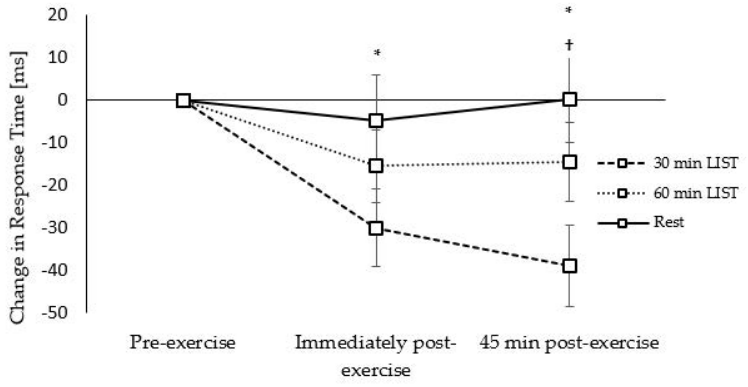
Figure 8. Change in response times across the morning on the 30 min LIST, 60 min LIST, and resting control trials on the congruent level of the Flanker task. Faster response times following 30 min LIST vs. rest * and 60 min LIST †; all p <